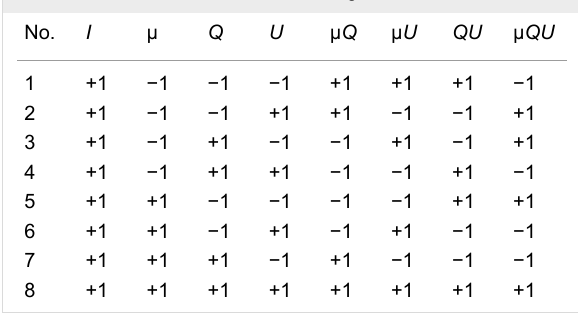
Table 6: Model matrix of a 2 3 factorial design.